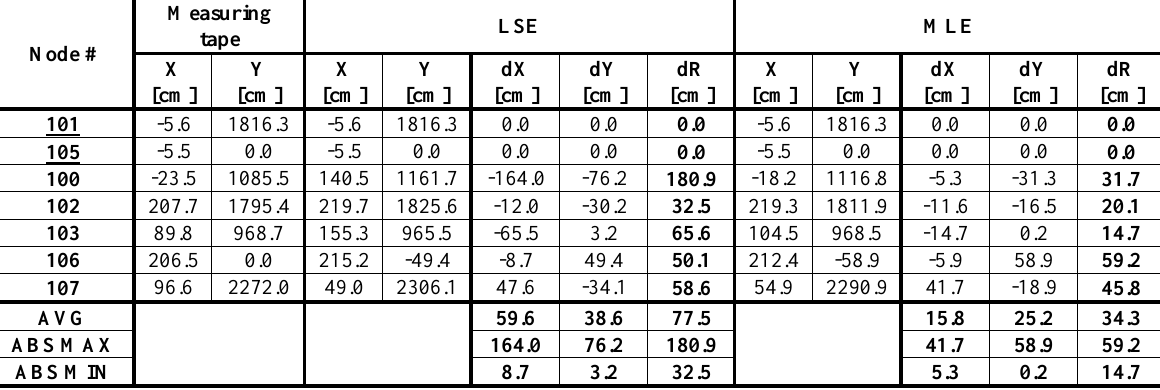
Table 1. Numerical comparison of LSE and MLE